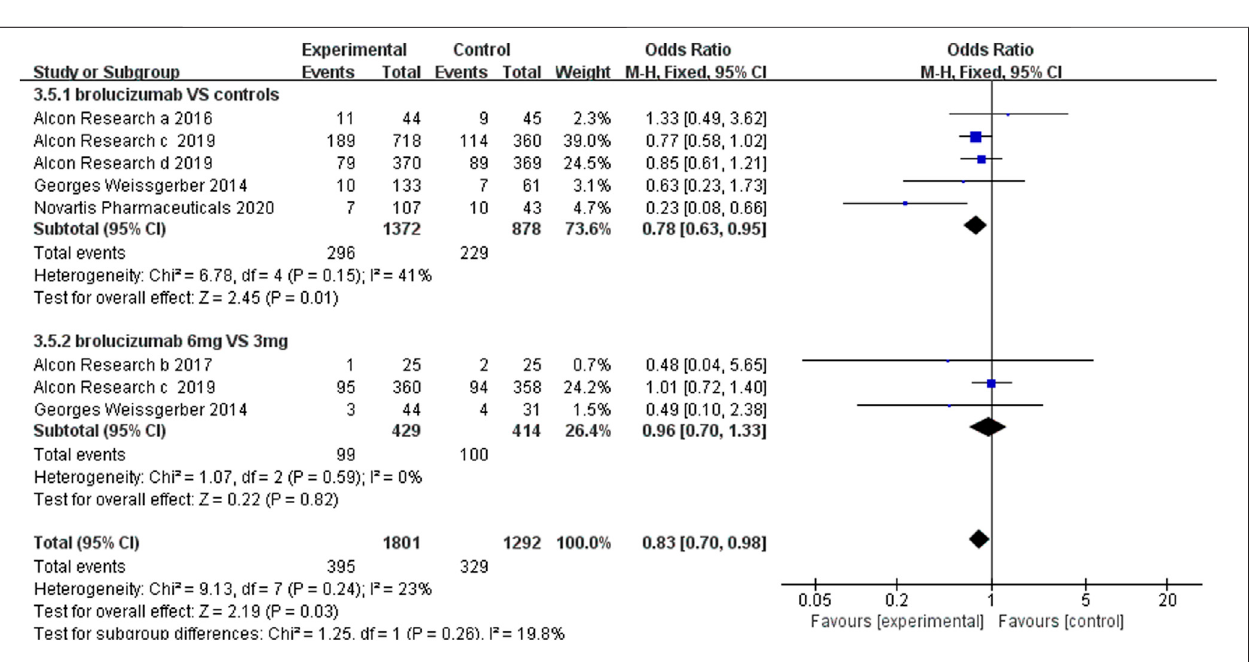
FIGURE 6 | Forest plots of the serious adverse